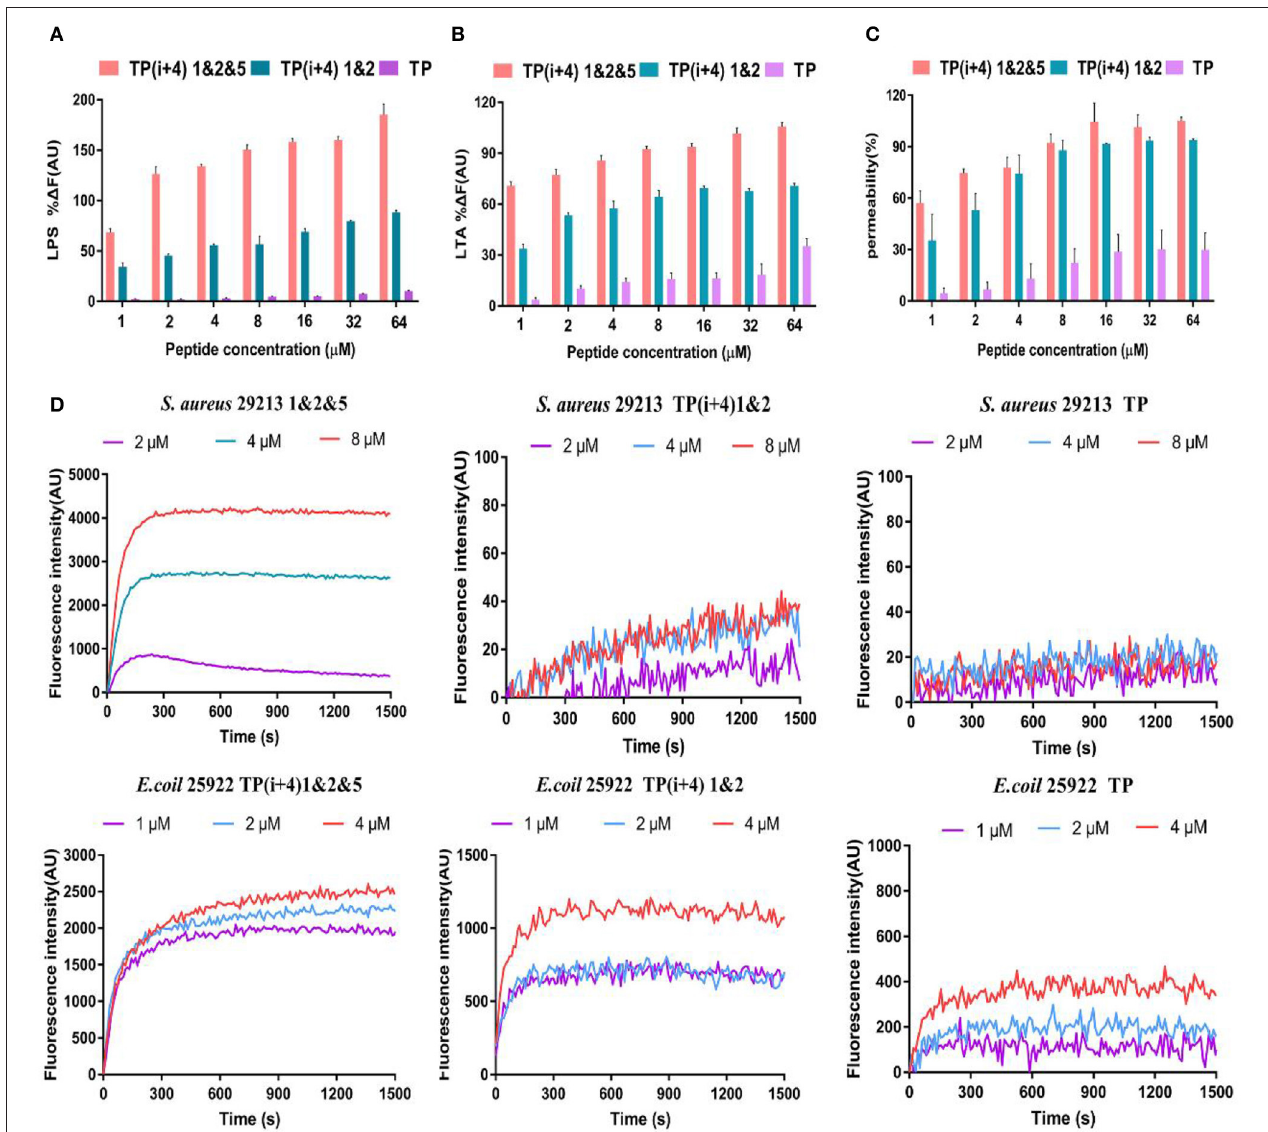
FIGURE 3 | The mechanism of action of peptides, (A) and (B) are polypeptides to bind binding capabilities on specific substances and LTA on the bacterial membrane. (C) OM permeability of the polypeptide. (D) Depolarize of the CM of the synthesis of the